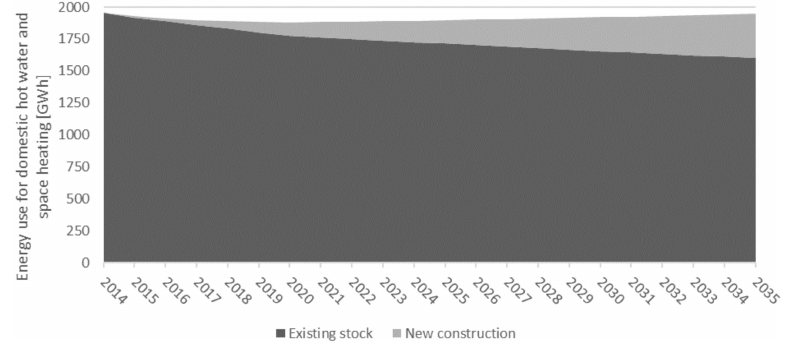
Figure 9. Future development of energy use for domestic hot water and space heating for the existing and future building stock until